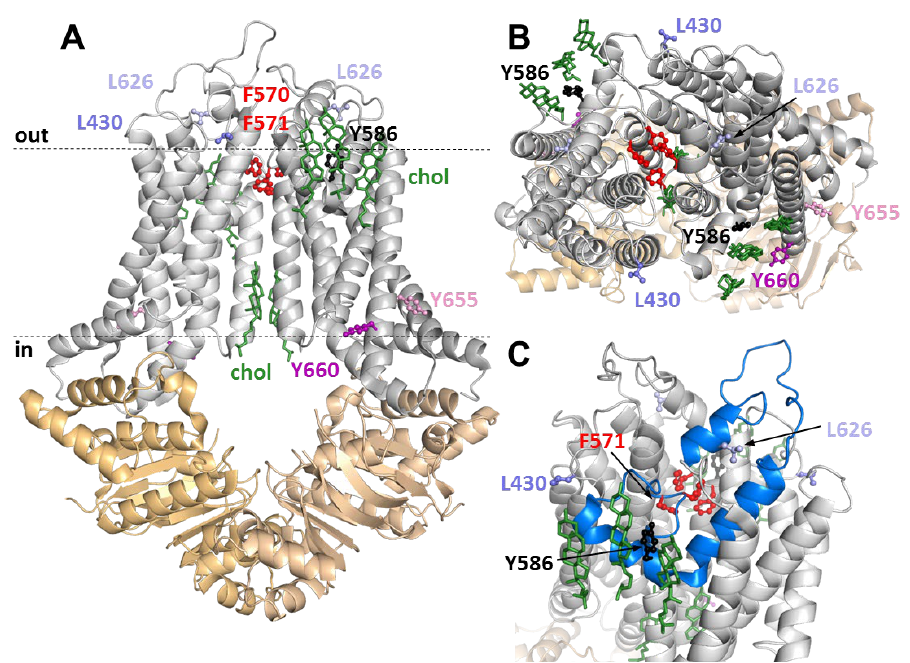
Figure 5. The homodimeric structure of ABCG1. Side view ( A ) and top view from the extracellular space ( B ) of ABCG1/ABCG1 (PDBID: 7r8d, G1-S). NBDs and TMDs are coloured in orange and gray, respectively. Cholesterol molecules resolved in the structure are shown by green sticks. F570 and F571, separating the main intracellular and extracellular substrate binding cavities, are red. The residues mutated in this study are shown in different colours, represented by sticks and balls, and labeled by residue numbers. ( C ) The residue Y586 (black), which is located in TM5b of the reentry G-loop (blue), interacts with one of the cholesterol molecules. Parts of the extracellular loop until the helix, including L626, are also coloured in blue. Dashed lines indicate the approximate location of the lipid bilayer and the hydrophobic membrane-embedded region of the protein.